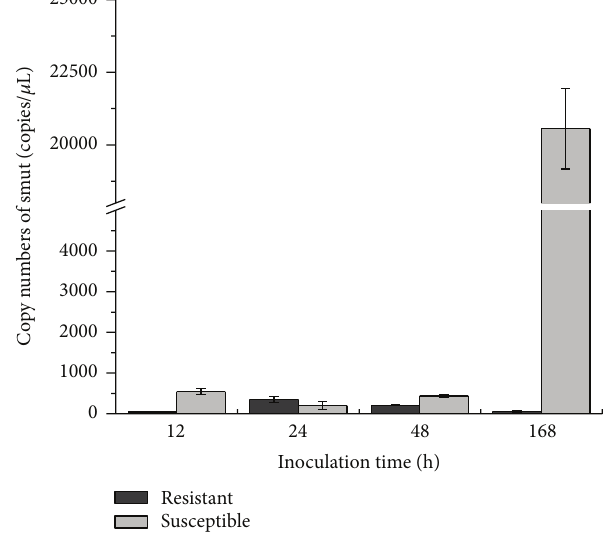
Figure 6: Quantification of the pathogen in sugarcane genotypes challenged with S. scitamineum . Resistant: Yacheng05-179; suscep- tible: “ROC”22. Copy numbers of smut were calculated with the equation of the linear regression line. All data points mean ± SE ( 𝑛 = 3